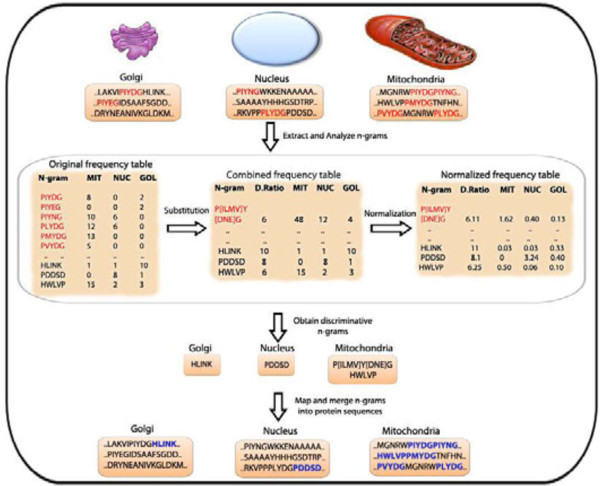
A schematic diagram showing the methodology and scoring function. GOL – Golgi; MIT – Mitochondria; NUC – Nuclear.